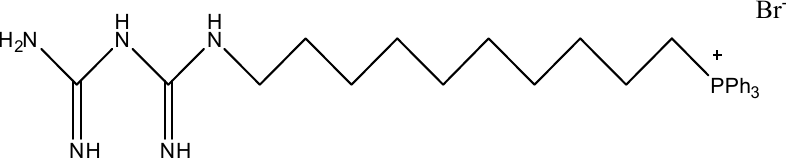
Figure 1. Chemical structure of Mito-metformin10 (MM10).